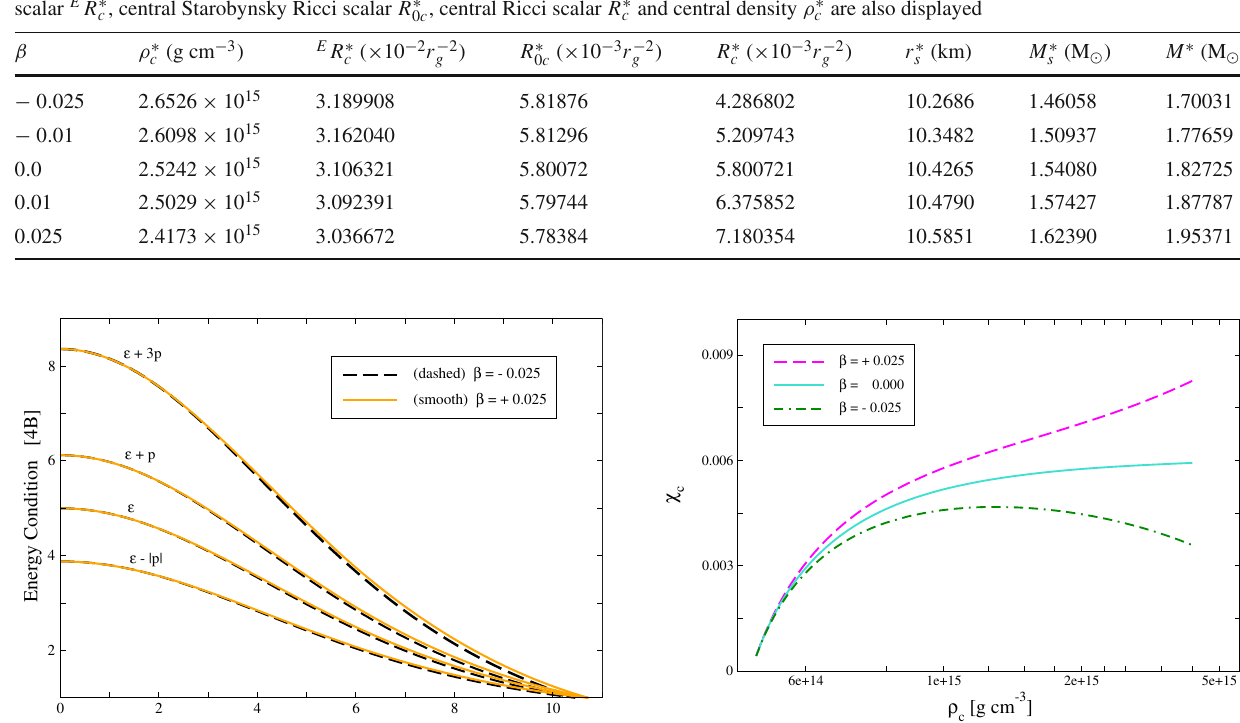
graphs in Fig. 10 that the radius of the halo r H decreases with increasing central density ρ c . At the same time, the value of r Sch = 2 GM increases with increasing central density ρ c , as c 2 seen from Fig. 7. These two opposite behaviours